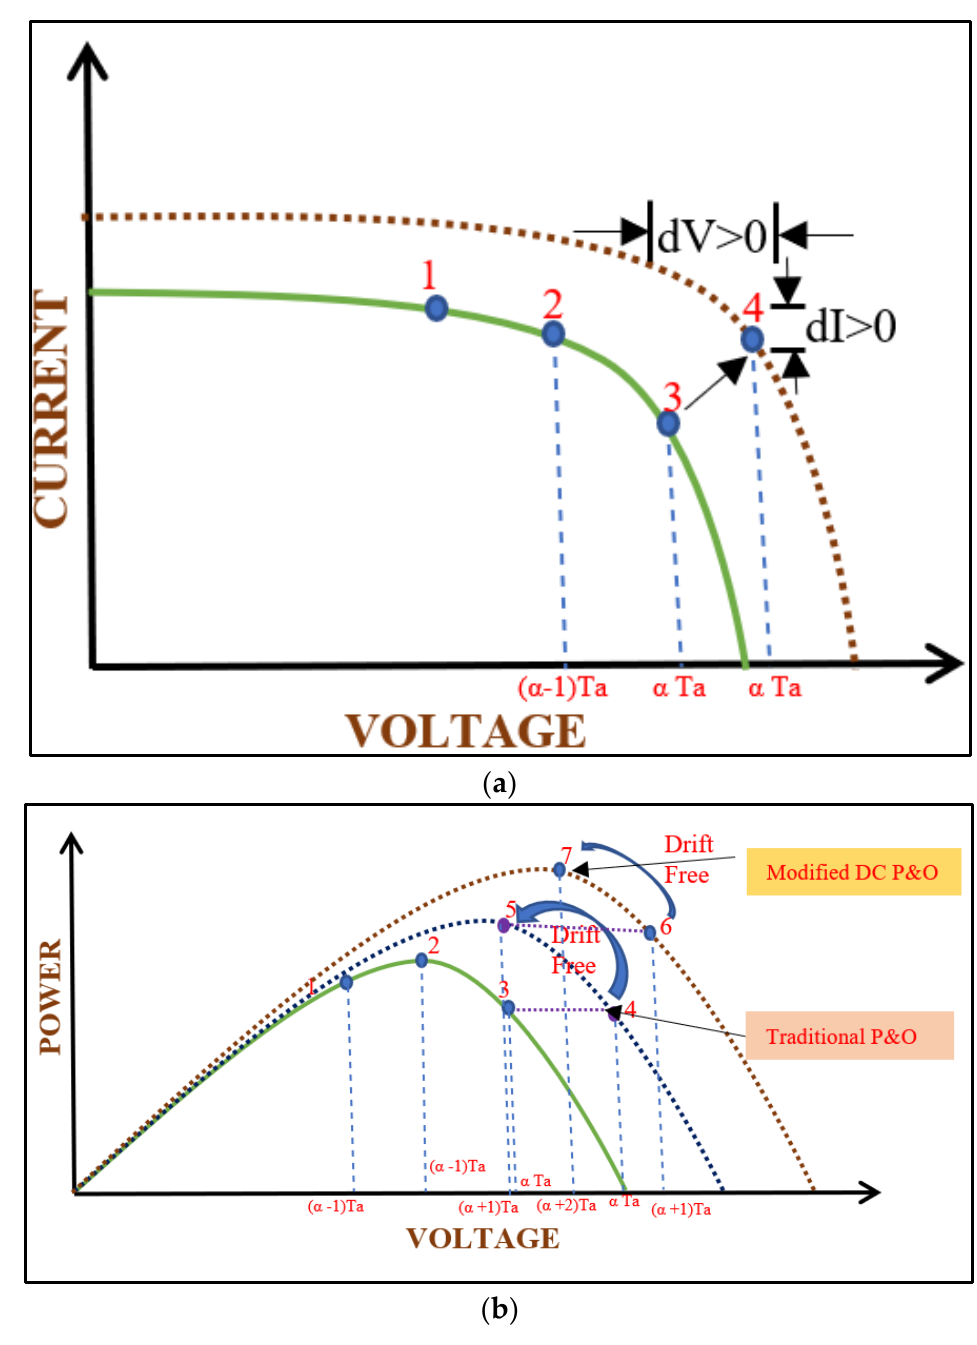
(cid:16) (cid:17) dV ; ( b ) modified DC-(P&O) with slope ; ( b ) modified DC-(P&O) with slope dI 𝑑𝑑𝑑𝑑 � 𝑑𝑑𝐼𝐼 �